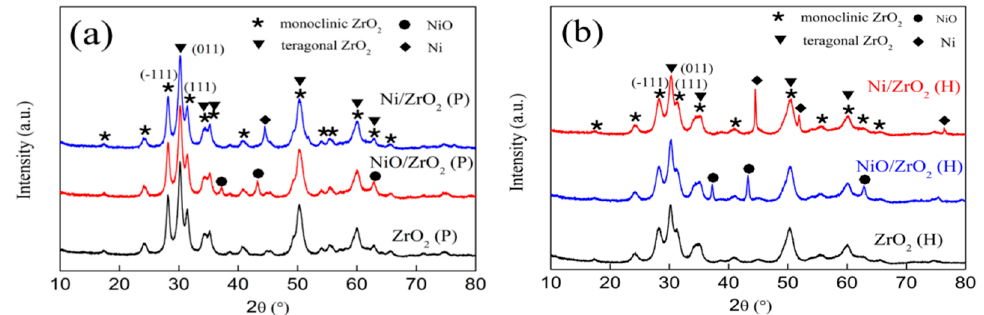
Figure 2. X-ray powder diffraction patterns of ( a ) ZrO 2 (P) support and supported Ni catalysts and ( b ) ZrO 2 (H) support and supported Ni